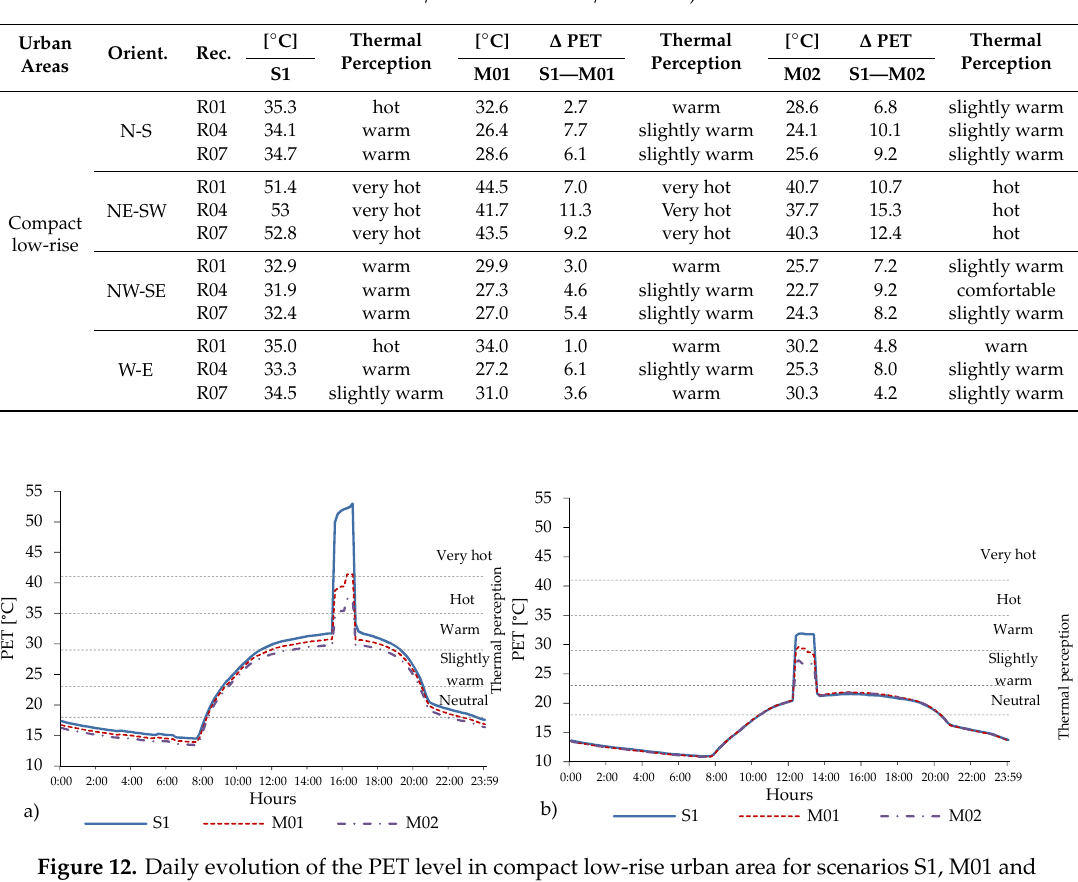
Figure 13. PET values registered in all 14 receptors in the compact mid-rise urban areas for scenario S1, M01 and M02 in all orientations.